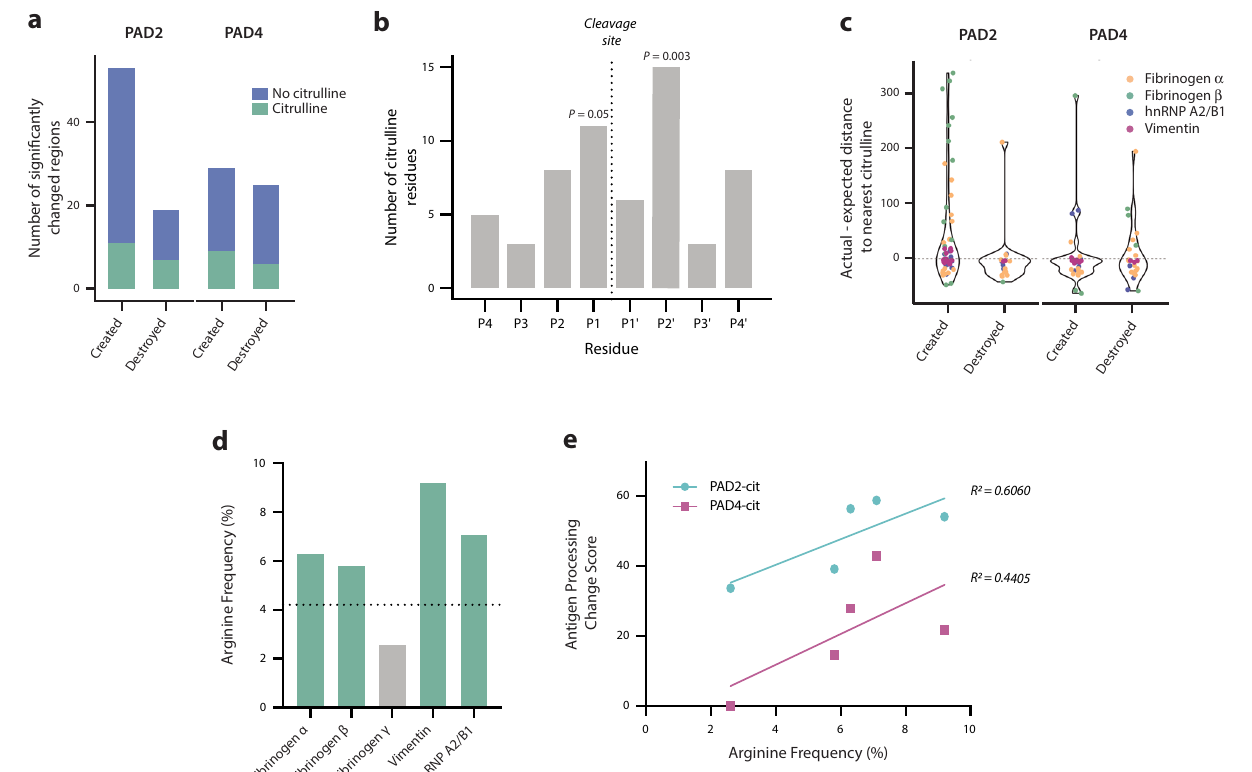
Fig. 2 | Citrullination induces proximal and distal changes in processing rela- tive to citrullinated sites. a Percentage of signi fi cantly created and destroyed regions derived from PAD2- and PAD4-citrullinatedantigens thatcontain citrulline residues. b Frequency of citrulline residues in each position (P4-P4 ’ ) of citrulline- containing cleavage sites enriched in the citrullinated antigens. P values were cal- culated via bootstrapping to compare the observed frequency of citrullines to the expected frequencyof citrullinesineachposition.Onlysigni fi cant P values( ≤ 0.05)